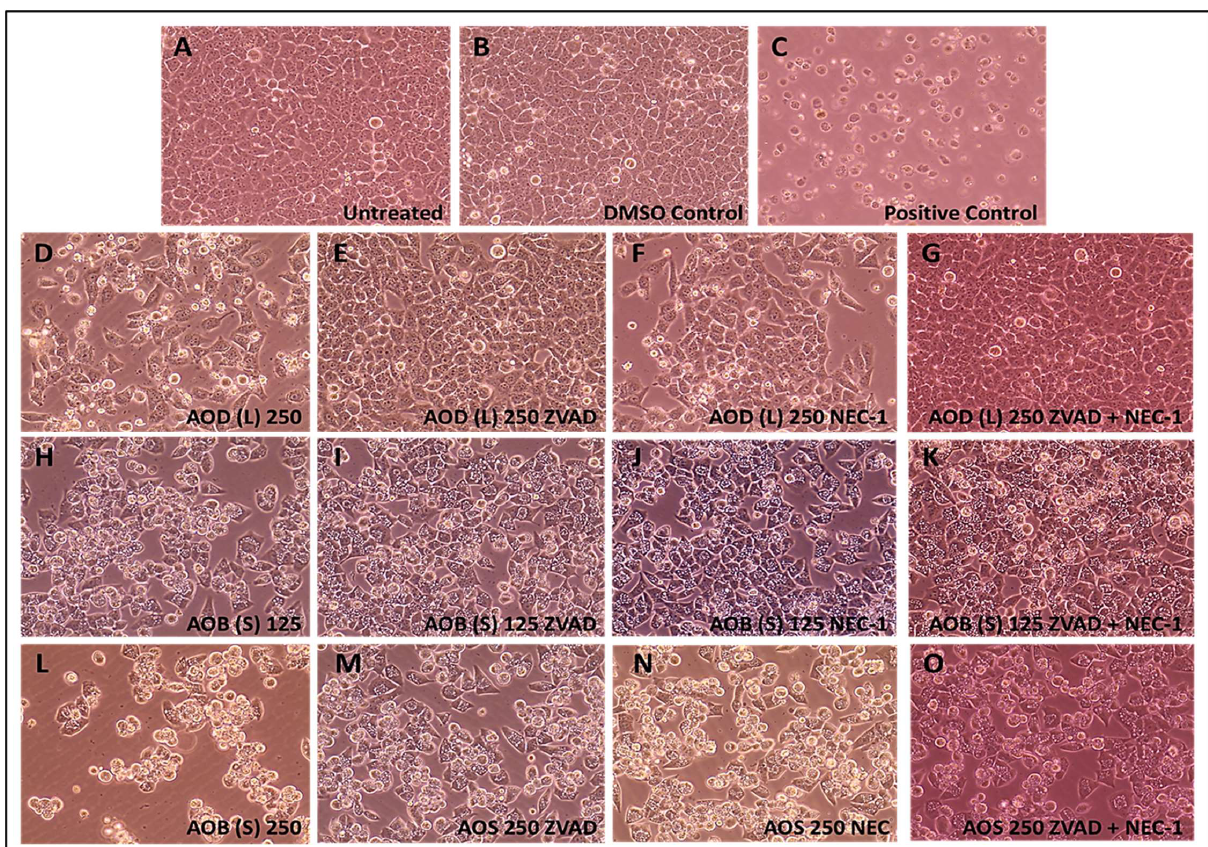
Figure 8. Photomicrographs of HeLa cells treated with 250 µg/mL of the A. orientalis dichloromethane leaf (AOD (L)) fraction or 125 and 250 µg/mL n-butanol stem (AOB (S)) fraction for 24 h. Samples: ( A ) Untreated; ( B ) DMSO control; ( C ) Positive control-treated; ( D ) 250 µg/mL AOD (L)-treated; ( E ) 250 µg/mL AOD (L)-treated cells pretreated with ZVAD, or ( F ) NEC-1, or ( G ) both; ( H ) 125 µg/mL AOB (S)-treated; ( I ) 125 µg/mL AOB (S)-treated cells pretreated with ZVAD, or ( J ) NEC-1, or ( K ) both; ( L ) 250 µg/mL AOB (S)-treated; ( M ) 250 µg/mL AOB (S)-treated cells pretreated with ZVAD, or ( N ) NEC-1, or ( O ) both. ZVAD = Z-VAD-FMK; NEC-1, Necrostatin 1. The DMSO Control sample contains the same amount of DMSO as in the 250 µg/mL sample of the treatment. Magnification: 400×.